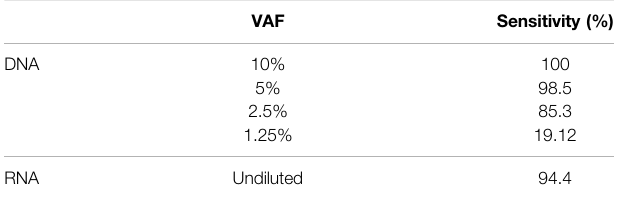
TABLE 1 | Mean sensitivity across the studied variants obtained for DNA at different VAF and for the undiluted